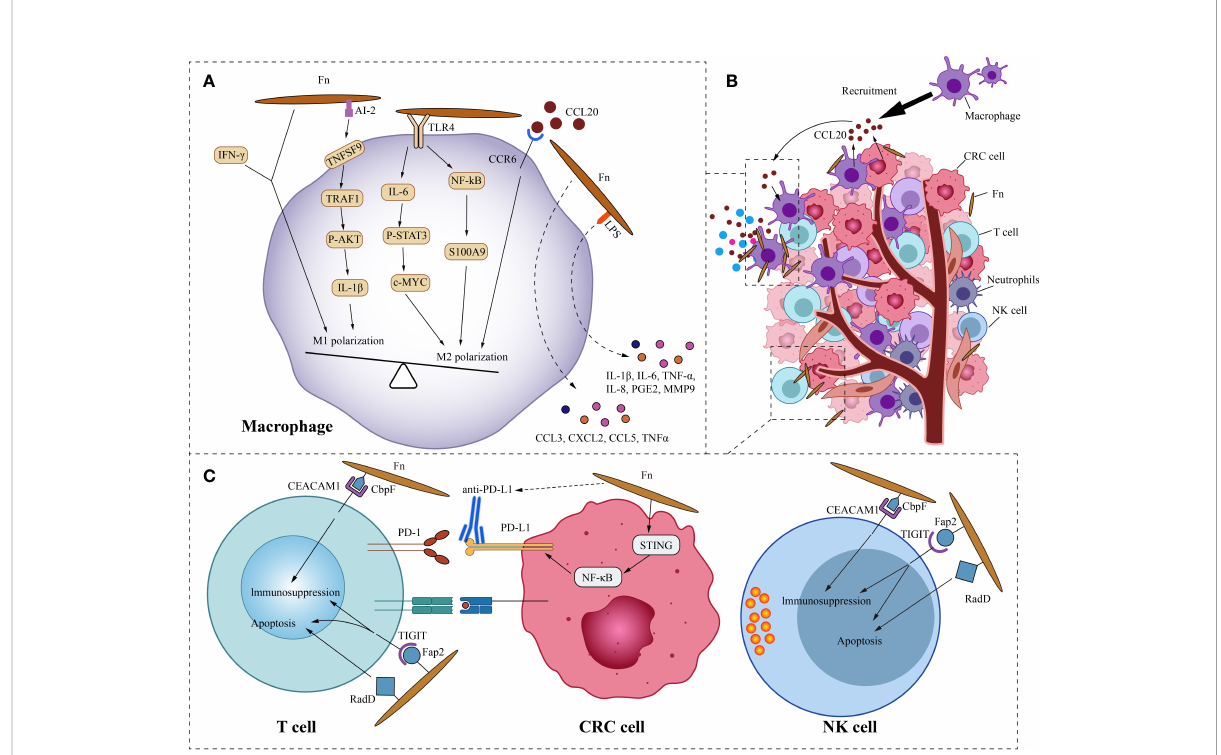
FIGURE 3 Fn interacts with CRC immune microenvironment. (A) This is the schematic diagram of communication of Fn and CRC immune microenvironment. (B) In general, Fn induces macrophages to M2 polarization. Fn promotes macrophages M2 polarization by activating TLR4/ IL6/p-STAT3/c-Myc and NFKB/S100A9 signals. But some components such as AI-2 of Fn and IFN- g induced by Fn mediate macrophages MI polarization. CRC cells and macrophages derived CCL20 induced by Fn infection also promotes macrophages M2 polarization. Other molecules derived from macrophages induced by Fn may also have important effects in the immune microenvironment, such as IL-6, IL-1 b , TNF-a, IL-8, PGE2 and MMP9. (C) Fn binds to the inhibitory receptors TIGIT and CEACAM1 on T cells and NK cells through Fap2 and CbpF, respectively, to mediate their immunosuppression and apoptosis. Fn upregulates the expression of PD-L1 in CRC cells by activating the STING/NFKB axis, and enhances the response of CRC to PD-L1